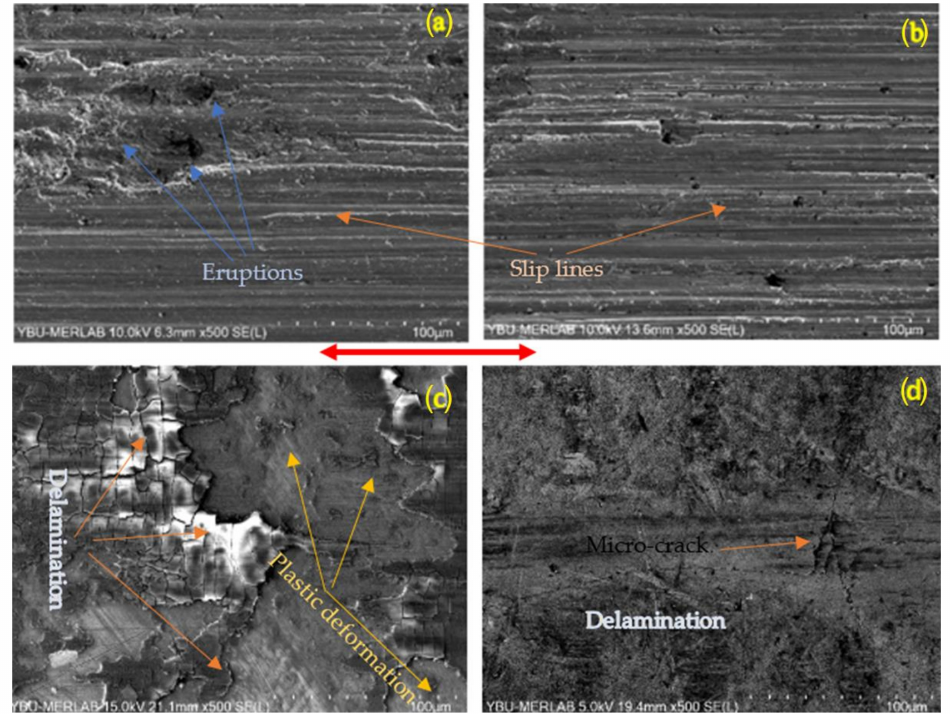
Figure 6. Wear traces of substrates: ( a ) non-heat-treated and ( b ) heat-treated Ti-6Al-4V; ( c ) non-heat- treated and ( d ) heat-treated